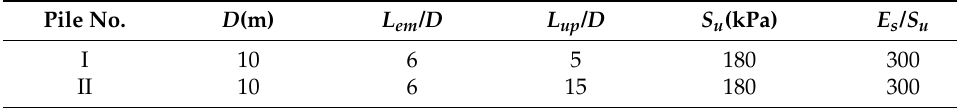
Table 4. Parameters of monopiles and soil condition for case